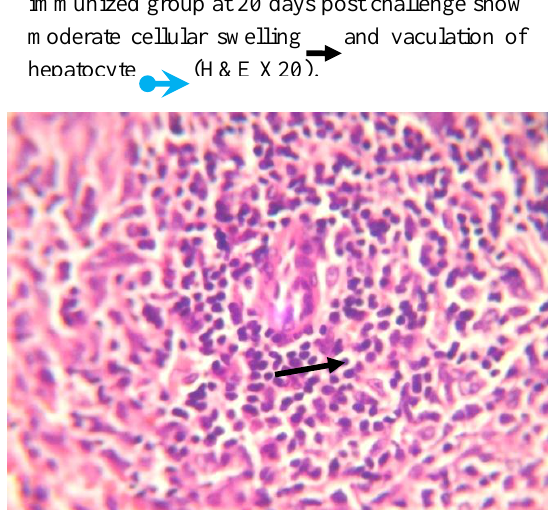
Fig 11: Microscopic section of spleen from 1st immunized group at 20 days post challenge show lymphoid hyperplasia of white pulp (H&E